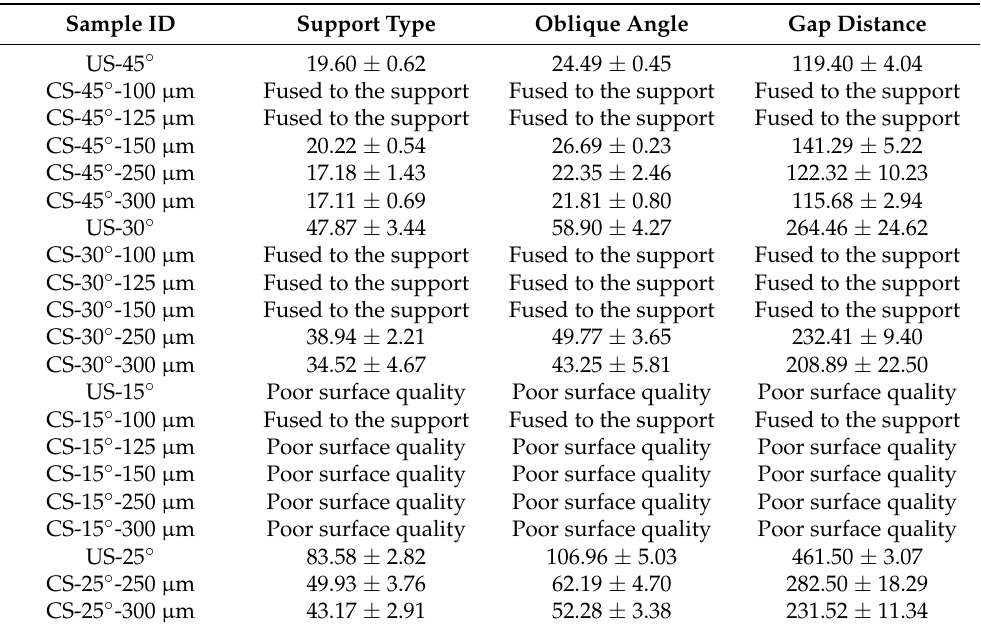
Table 3. Ra, Rq, and Rz values obtained from the overhang surfaces of different oblique angles (15 ◦ , 30 ◦ and 45 ◦ ) and gap distances (unsupported, 100, 125, 150, 250, and 300 µ